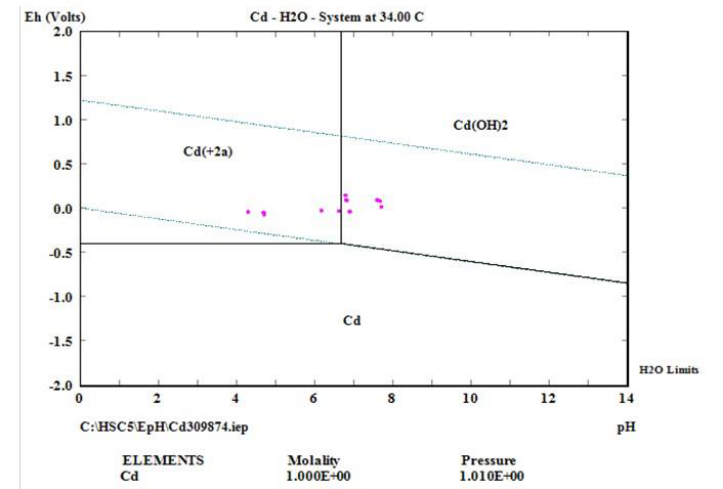
Fig.6 (b): Speciation of Cd in different Eh values in Tehran rainwater samples after the PEC process